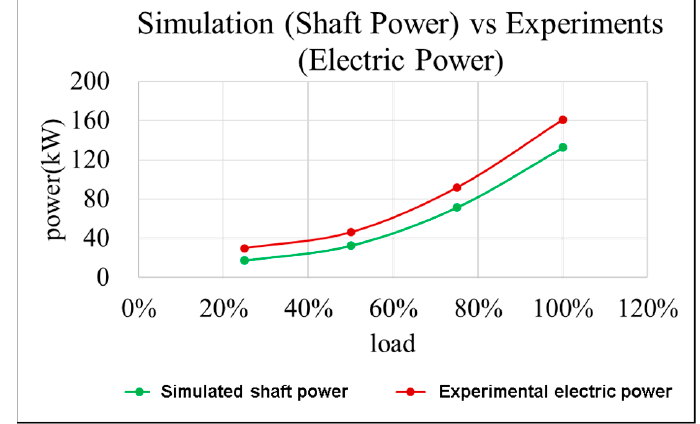
13 of 22 Figure 9. Comparison diagram of total pressure ratios of simulation and experiment. Relative error = |A − B| B (16) Table 6. Comparison of total pressure ratio between CFD simulation and Experiment. Load, %